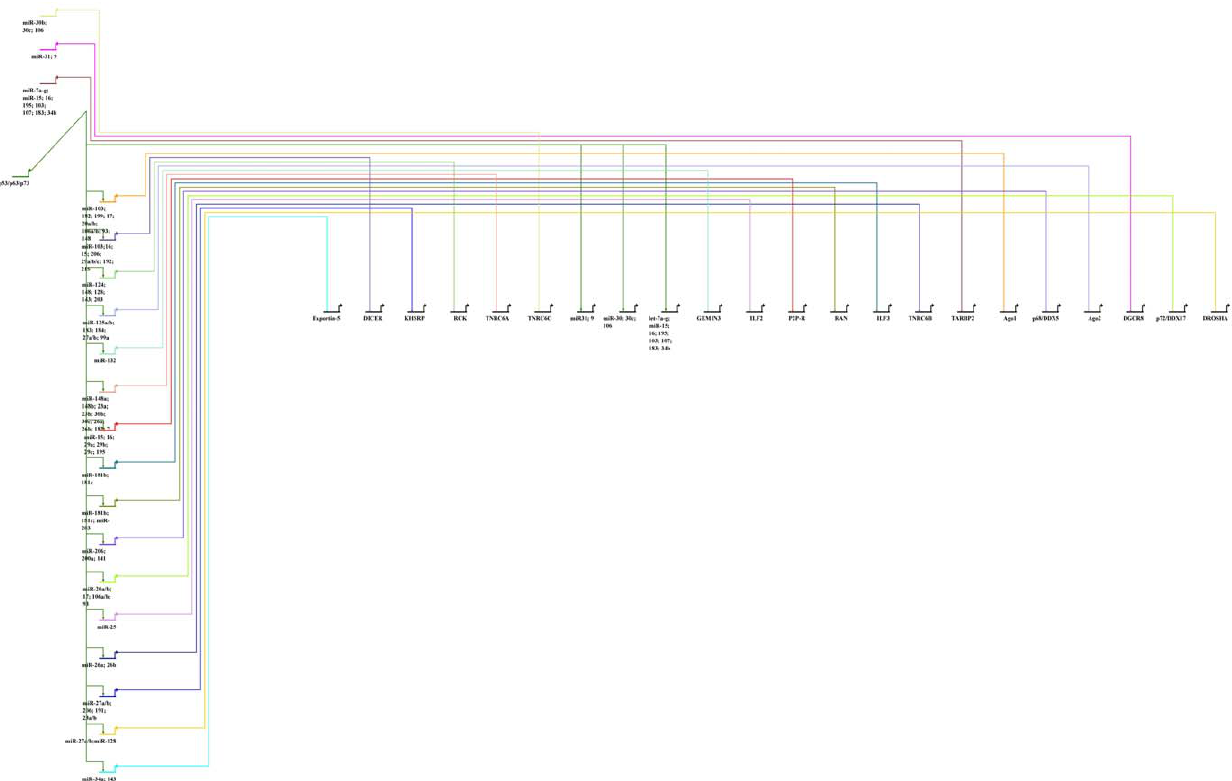
Figure 5. This working model shows how p53, p63, p73, and their target miRNAs regulate the microRNA-processing components. It was drawn using biotapestry software [87]. doi:10.1371/journal.pone.0010615.g005 PLoS ONE |